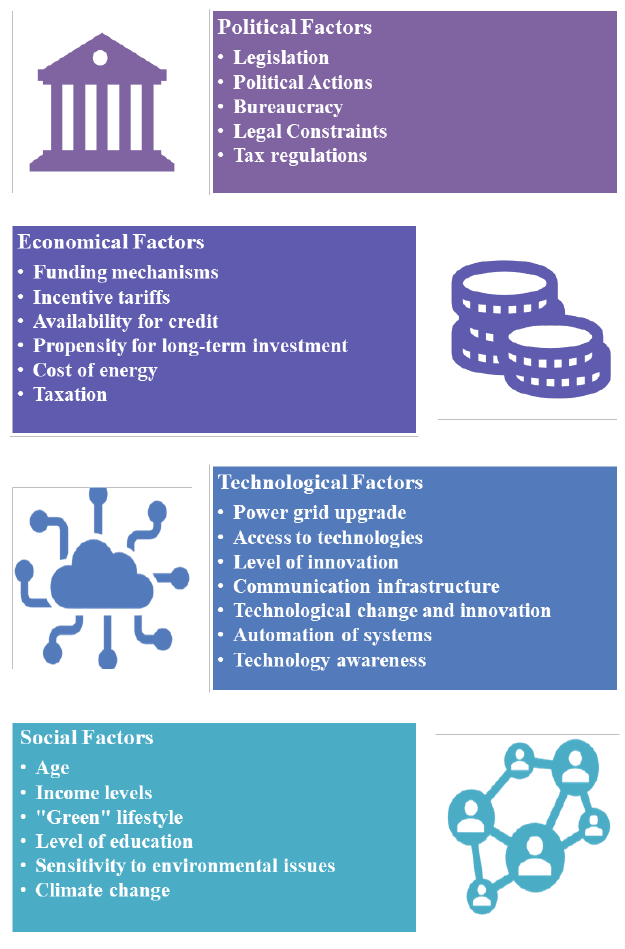
Figure 4. PEST analysis.